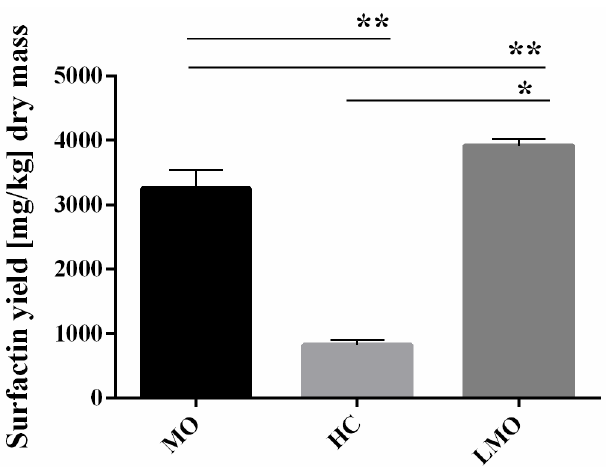
Figure 8. Surfactin yield obtained with B. subtilis 87Y during 24h of SSF on milled oats (MO), hulled caryopses (HC) and large fragments separated from milled oats (LMO). Statistical significance in all cases is presented as follows: * p < 0.05; ** p < 0 .01